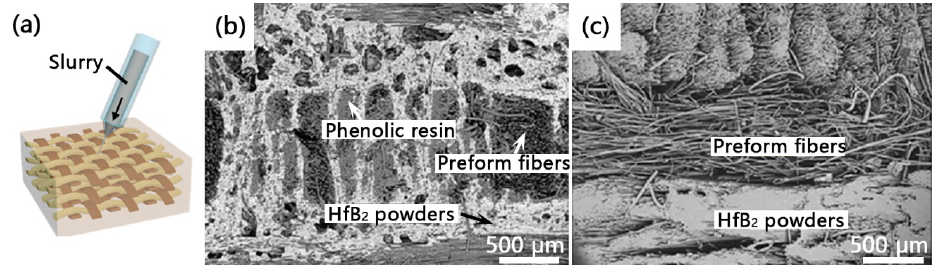
Fig. 17 Schematic diagram of slurry injection (a), microstructure of the C f /HfB 2 composites fabricated by slurry injection (b), and slurry impregnation (c). Reproduced with permission from Ref. [228], © Elsevier Ltd. 2019.